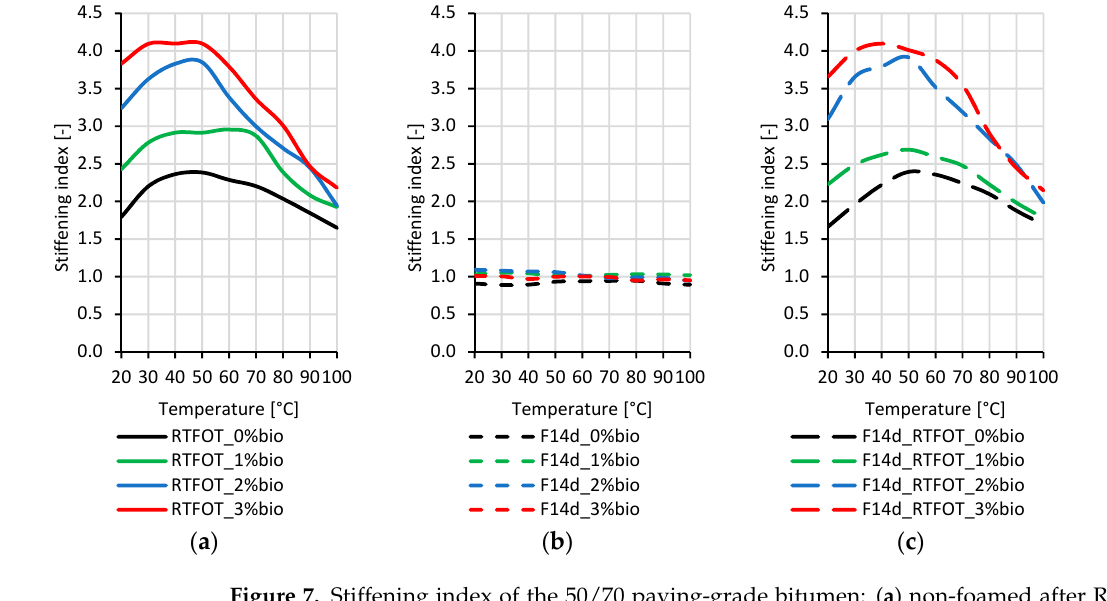
Figure 7. Stiffening index of the 50/70 paving-grade bitumen: ( a ) non-foamed after RTFOT ageing bitumen (RTFOT); ( b ) foamed original bitumen (F14d); ( c ) foamed after RTFOT ageing bitumen (F14d_RTFOT).